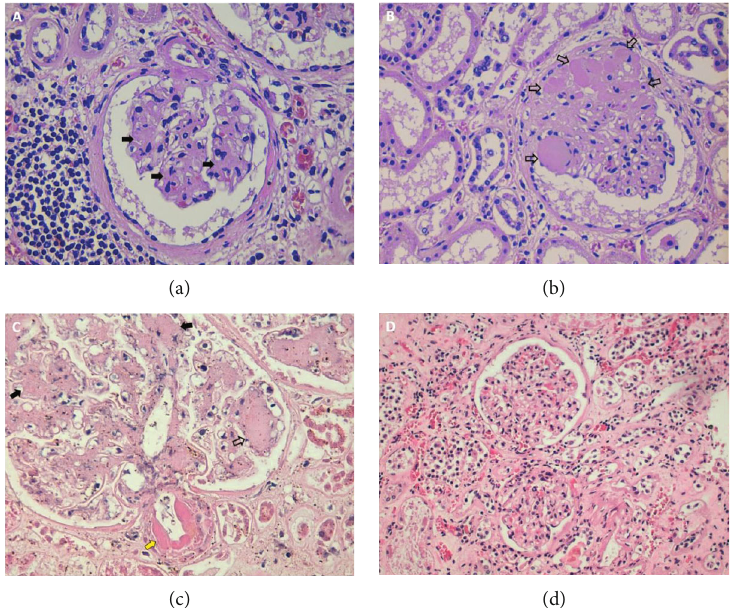
Figure 1: Kidney histological fi ndings. (a) HE 400x, glomeruli with mild mesangial expansion (black arrows) and Bowman ’ s capsule fi brosis. Findings of chronic interstitial fi brosis and tubular atrophy (IFTA) on the left side of the fi gure, in a nonalbuminuric diabetic subject. (b) HE 400x, nodular lesions (Kimmelstiel-Wilson) (empty arrows) that correspond to a class III: nodular sclerosis in the histologic classi fi cation system, in a diabetic albuminuric subject. (c) HE 400x, severe mesangial expansion, Kimmelstiel-Wilson nodules, and hyalinosis of e ff erent arteriole (yellow arrow) in a diabetic albuminuric subject. (d) HE 200x, glomeruli with nonspeci fi c changes from a sample of the control